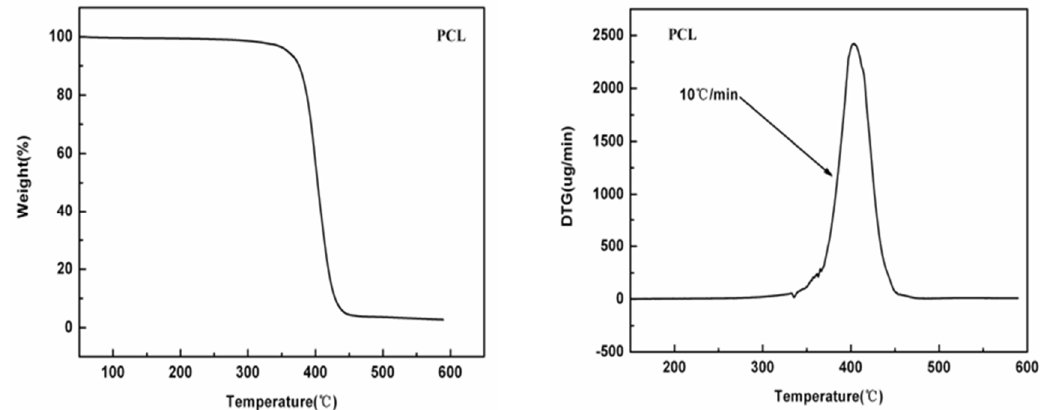
Figure 1. Thermogravimetric curve of the PCL porous film ( left ) and differential thermogravimetric curve of the PCL porous film ( right ).